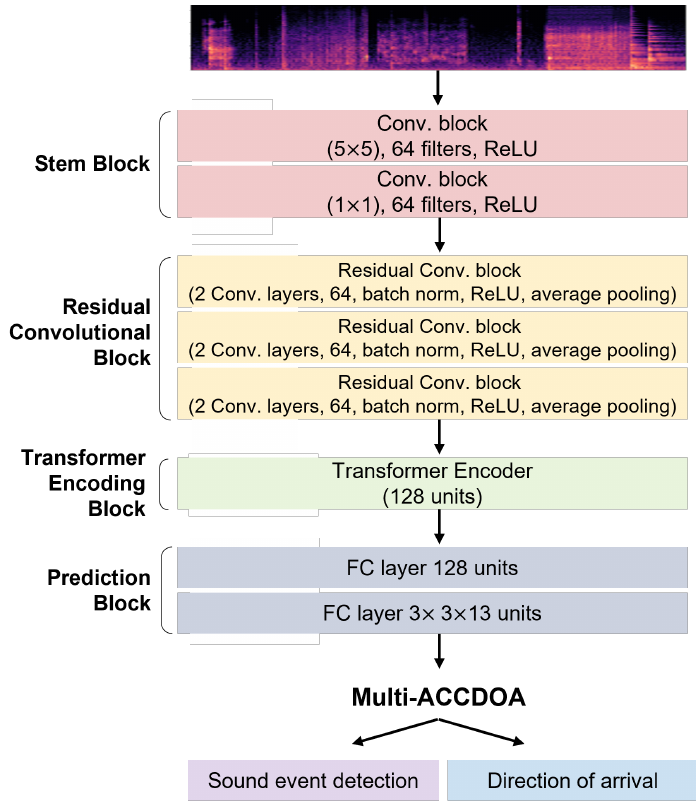
Figure 1. Architecture of the proposed RCNN and transformer-based model.